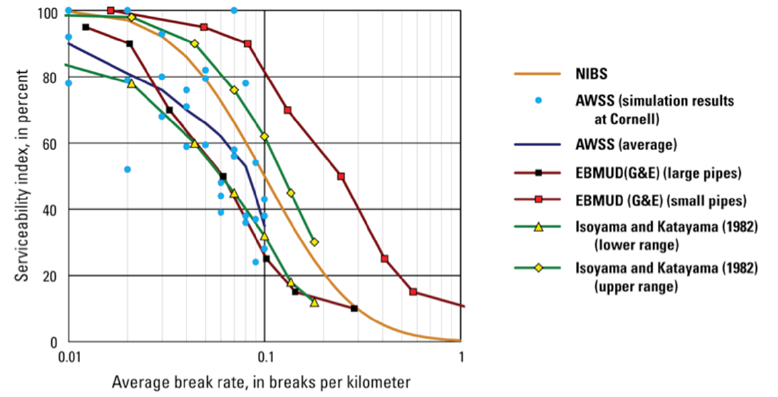
Figure 3. Graph showing Hazus water-pipe serviceability model and other models of water-pipe serviceability. Adapted from [1].